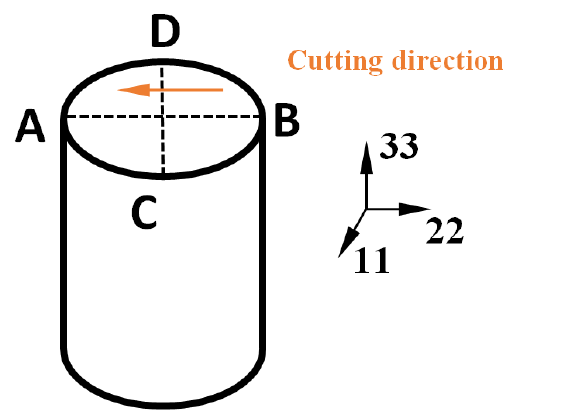
Figure 52. Specimen 5—line segments used for comparing stress levels on cut plane 2.